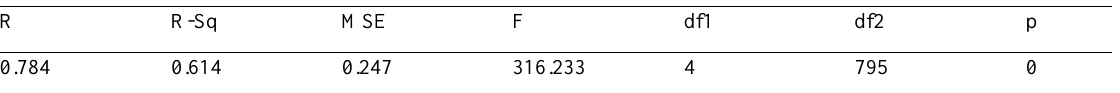
Table 6: Model Adequacy Summaries for Direct Effects of ECC, Mediating Variables on Entrepreneurial